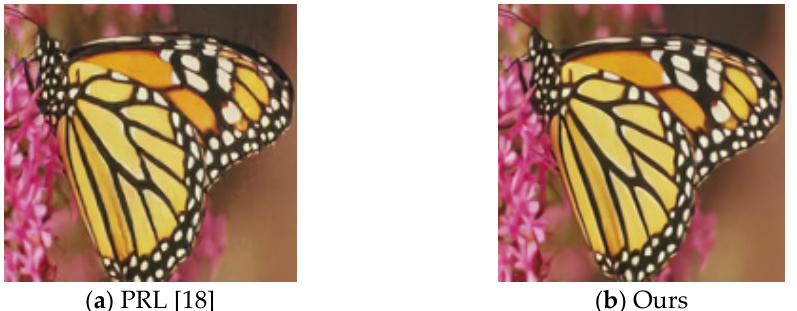
Figure 9. Comparison with texture restoration between PRL and Ours.